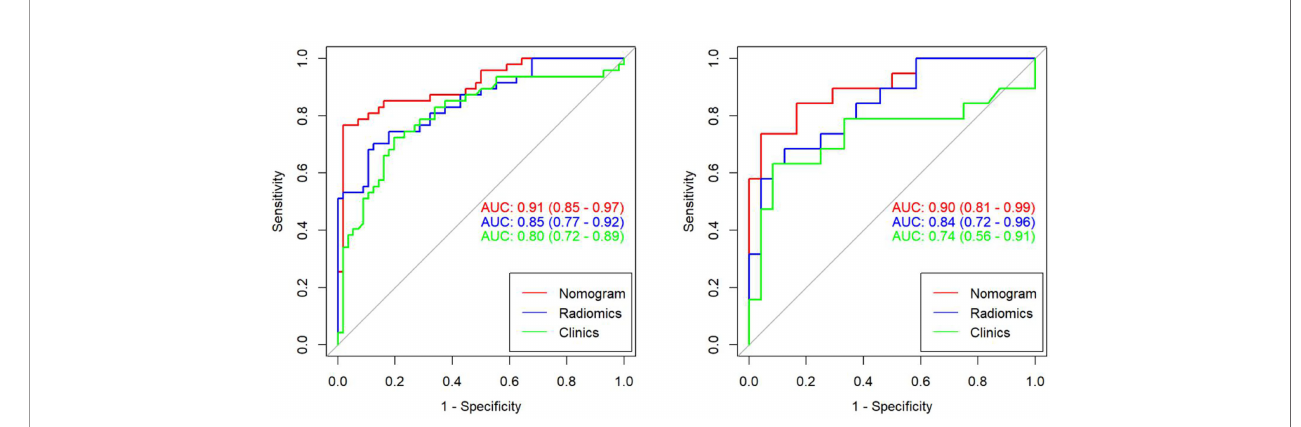
FIGURE 4 | The AUC values for radiomic signatures are used in identifying prostate cancer and prostatic hyperplasia. (Left: training set; right: